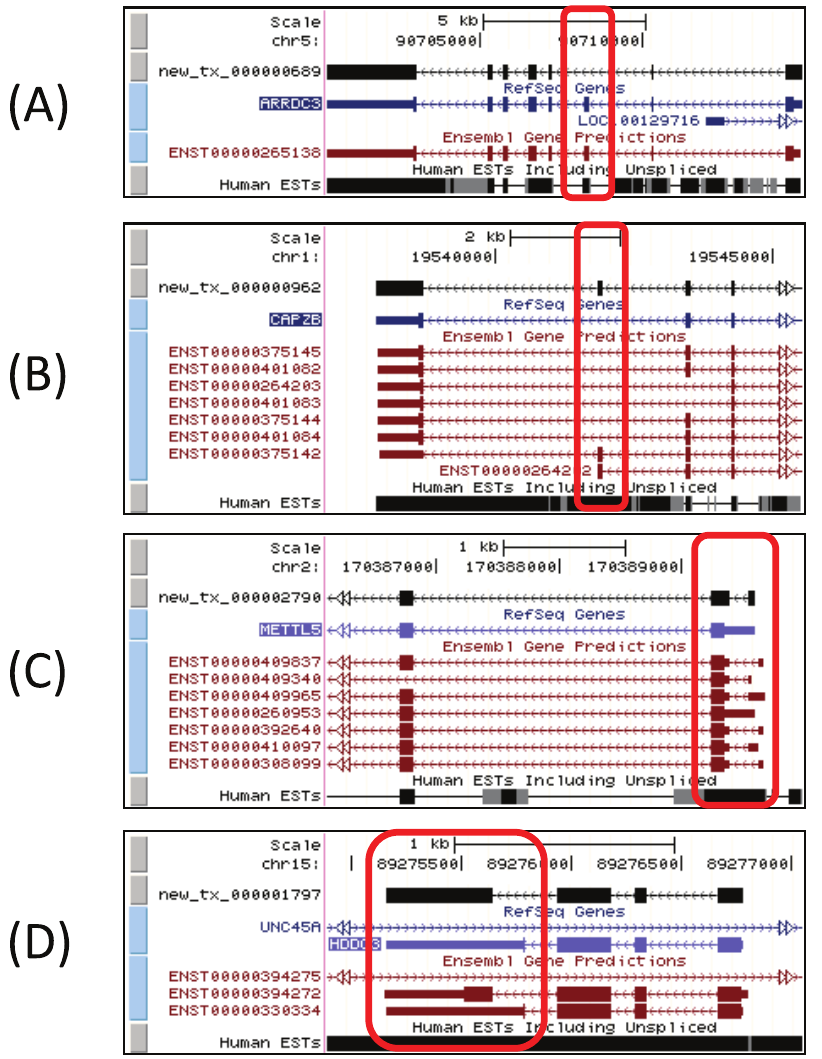
Figure 4. Types of alternative splicing events found in the newly reconstructed transcripts. These transcripts differ from the annotated transcripts of the same genes in RefSeq by ( A ) skipping a known exon, ( B ) inserting a new exon, ( C ) splitting a known exon, and ( D ) having a different end of a known exon. The first transcript track in black on top of each panel presents a reconstructed transcript, the second track in blue presents the annotated transcript in RefSeq which was used as the reference for the reconstruction, the third set of tracks in brown represent transcripts of the same gene in Ensembl, and the track in black at the bottom is a ‘dense’ presentation of the ESTs, because of the large number of ESTs.